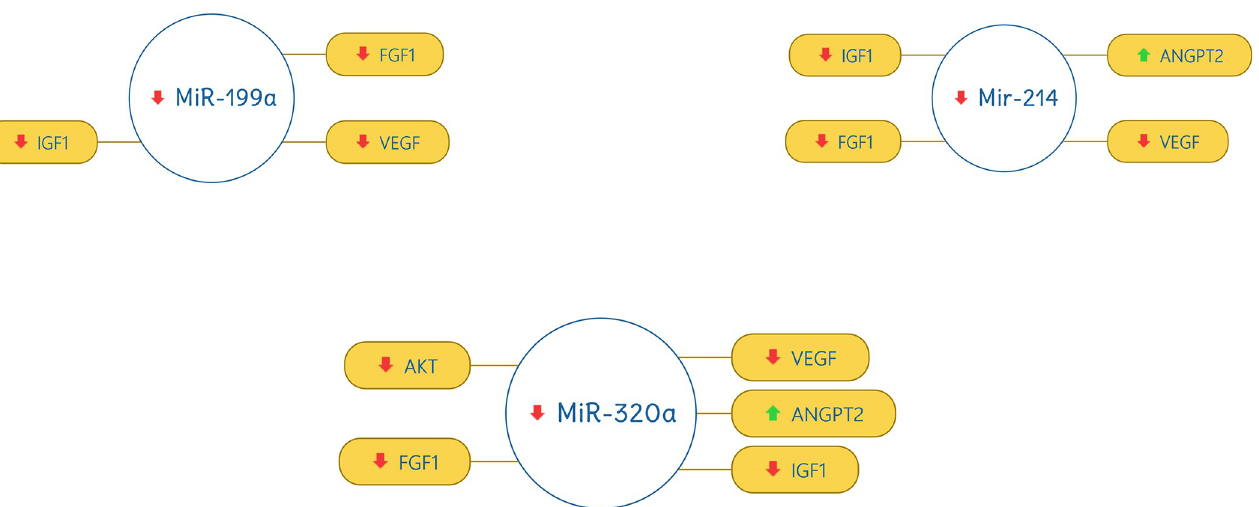
PLOS ONE | https://doi.org/10.1371/journal.pone.0250773 April 28,